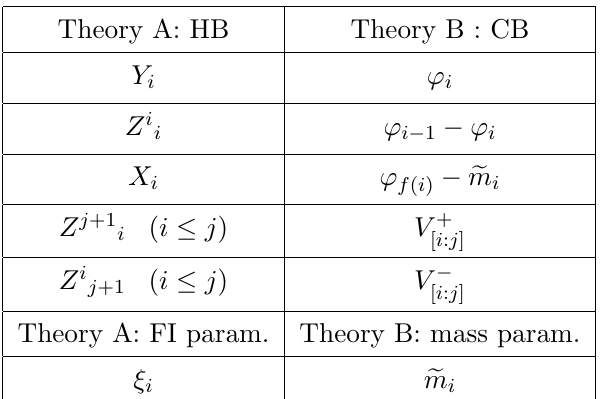
Table 6 . Mirror map of Higgs branch (HB) operators of T A and Coulomb branch (CB) operators of T B , and mirror map of FI and mass parameters. ’ under with the hyper-multiplet of mass